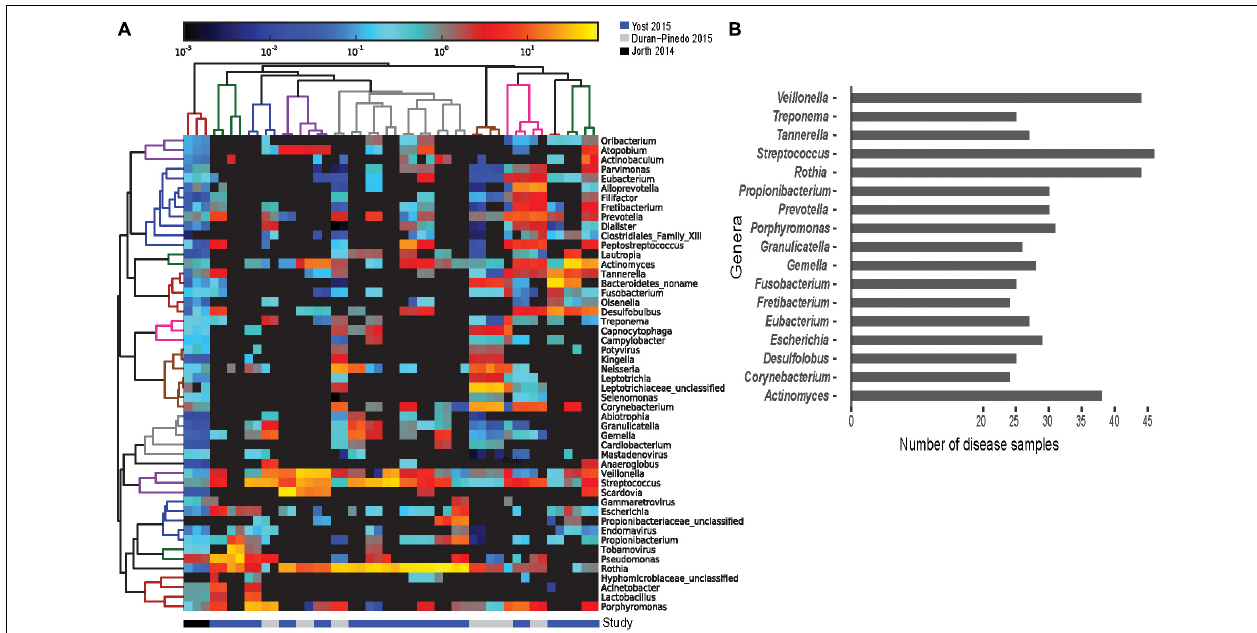
FIGURE 3 | Prevalence of functionally active taxa across disease samples. Screening for the functionally active microorganisms in the disease samples. (A) Heatmap of the 50 most functionally active genera from the overall dataset identified from the metatranscriptomes using HUMAnN2 (Abubucker et al., 2012). Gradient of color represents the abundance of the genus in a disease sample. Dendrograms represent hierarchical clustering of samples (column) and genera (rows) representing the similarity in the taxonomic composition between the samples and relative abundance of various genera, respectively. (B) Frequency distribution of the genera identified in at least 24 of the 48 disease samples. Streptococcus, Rothia, and Veillonella were found active in 40 out of the 48 disease samples. Porphyromonas, Tannerella, and Fusobacterium were found active in 30 samples or